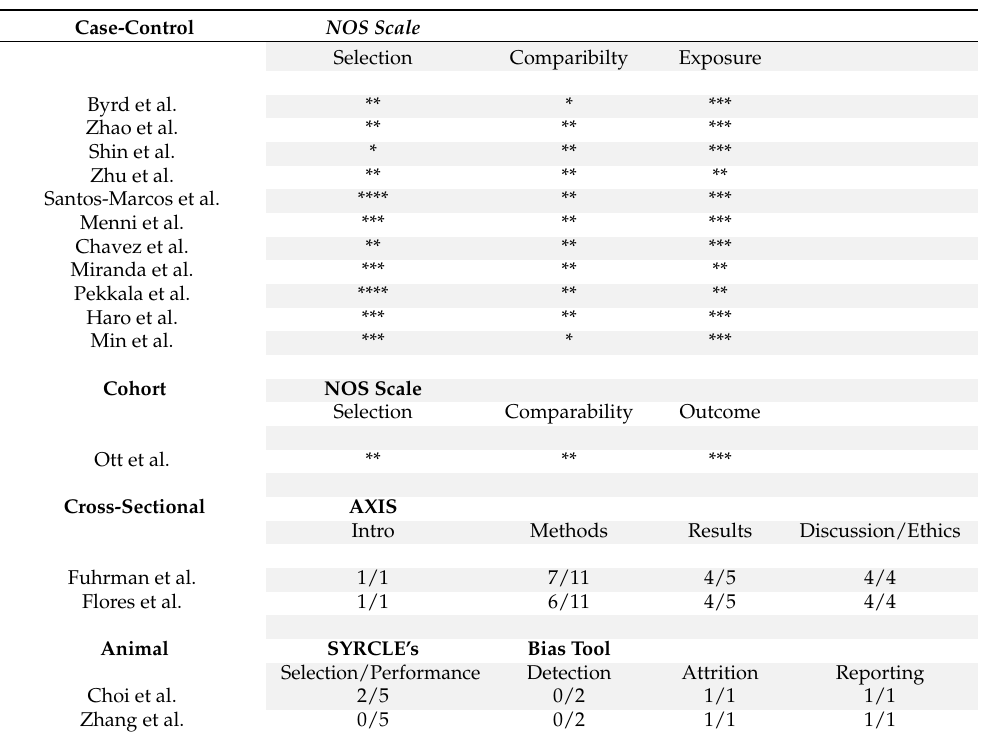
Table 3. Risk of bias, organized according to study